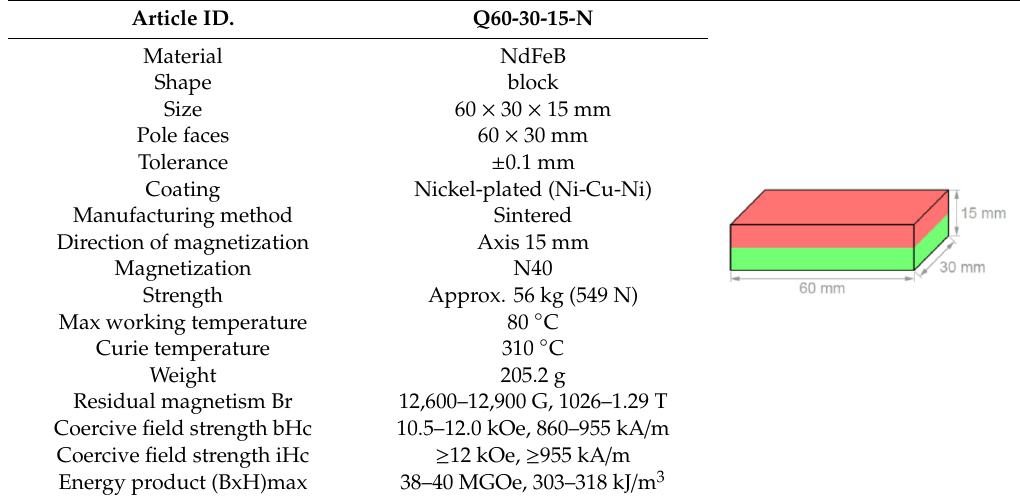
Table 1. Datasheet of permanent magnets [56]. Article ID.